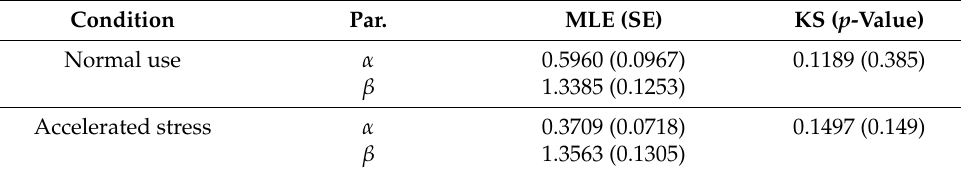
Table 7. MLEs and KS ( p -value) for LED